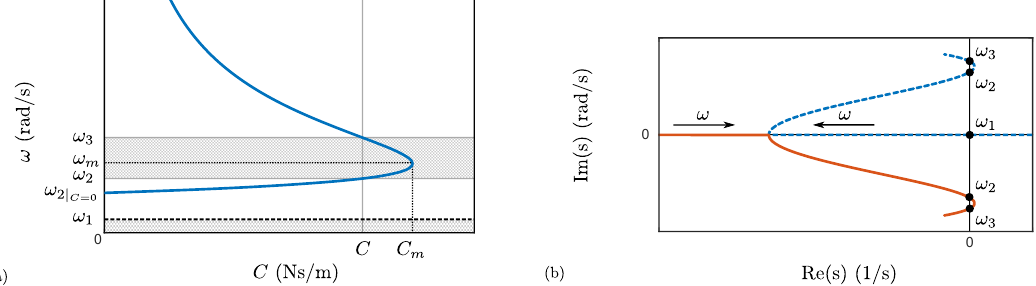
] : ( a ) evolution of the spin speeds ω 1 , ω 2 and ω 3 with the 2